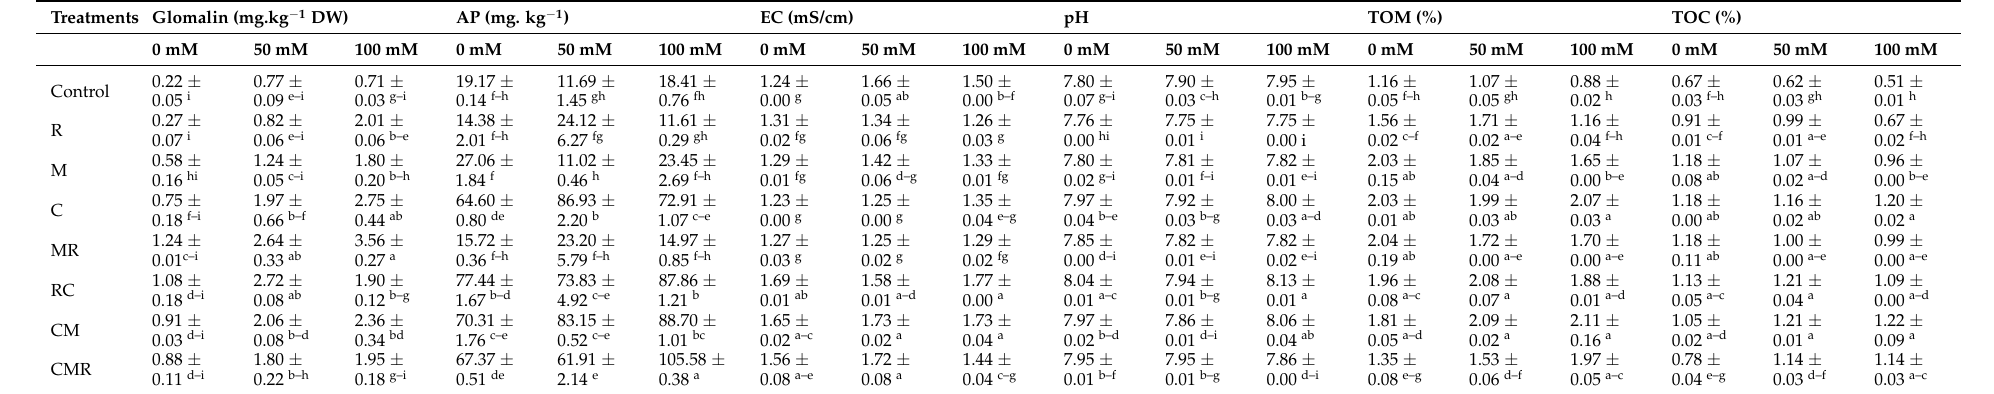
Table 4. Soil physicochemical analysis after harvest of lettuce grown under different salinity concentrations (0, 50, and 100 mM NaCl) of the control (unamended and uninoculated) and biofertilizer plants with composts (C), and/or arbuscular mycorrhizal fungi (M), and/or plant growth promoting rhizobacteria (R). Treatments Glomalin (mg.kg − 1